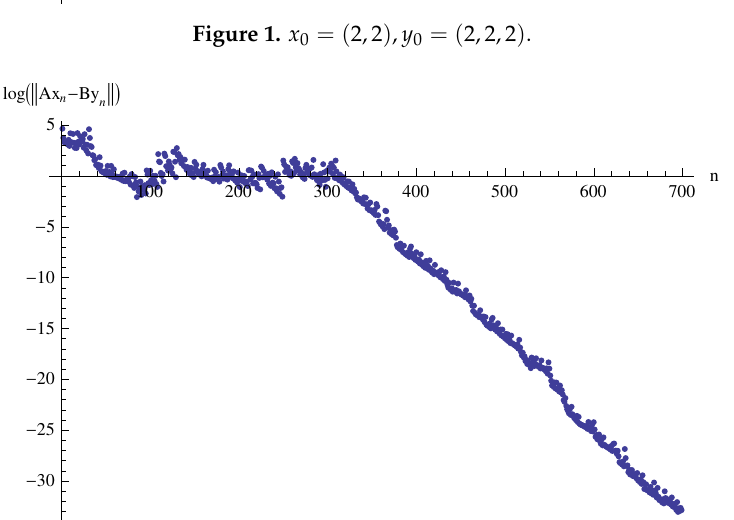
Figure 2. x 0 = ( 20,20 ) , y 0 = ( 10,10,10 )